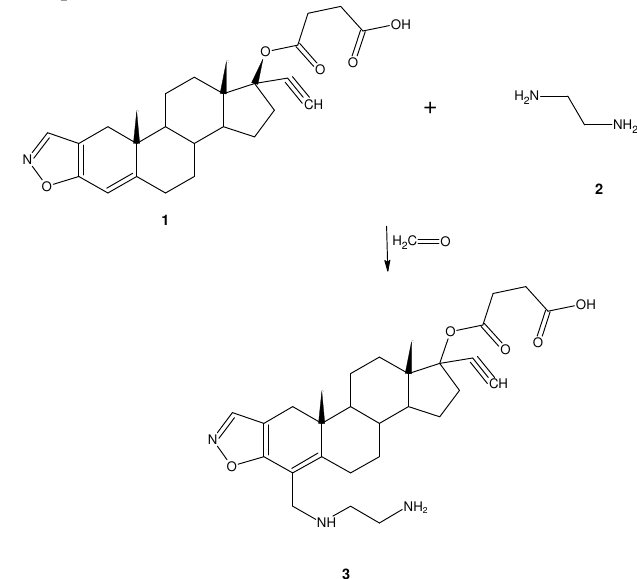
Figure 1. Synthesis of Succinic acid mono-{6-[(2-amino-ethylamino)-methyl]-1-ethinyl- 10a,12a- dimethyl-2,3, 3a, 3b,4,5,10,10a, 10b,11,12, 12a-dodecahydro-1 H -7-oxa-8-aza-